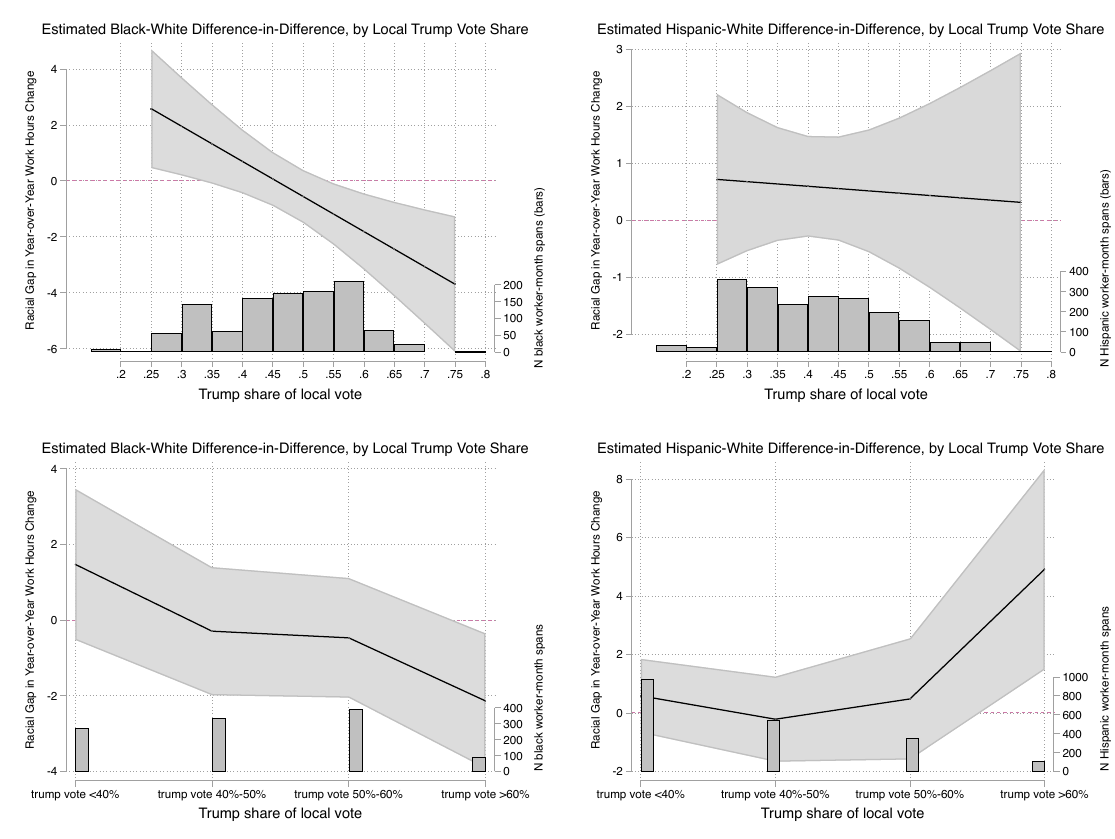
Figure 3: Estimates of racial disparities in workers’ year-over-year weekly work hours change, pre- and post- 2016 election. Notes: Estimates from lagged dependent variable models estimated on sample of prime-age hourly workers employed in the same job year-over-year from November 2015 to March 2017. Models include CBSA, industry, and occupation fixed effects. The top two panels are based on model 3 in Table 2. The bottom two panels use an equivalent specification but substitute a binned measure of Trump vote share. Probability weights are applied to adjust for survey design, sample attrition, and attrition from wave 1 hourly job. Standard errors are clustered by